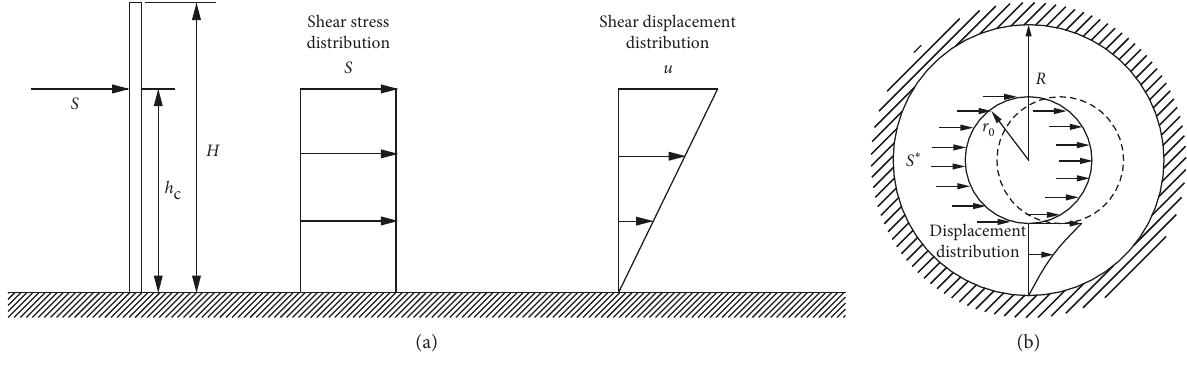
Figure 8: Relationship between the concentrated force and ground shear deformation along the transverse direction of a tunnel in (a) the actual ground and (b) the axisymmetric model.